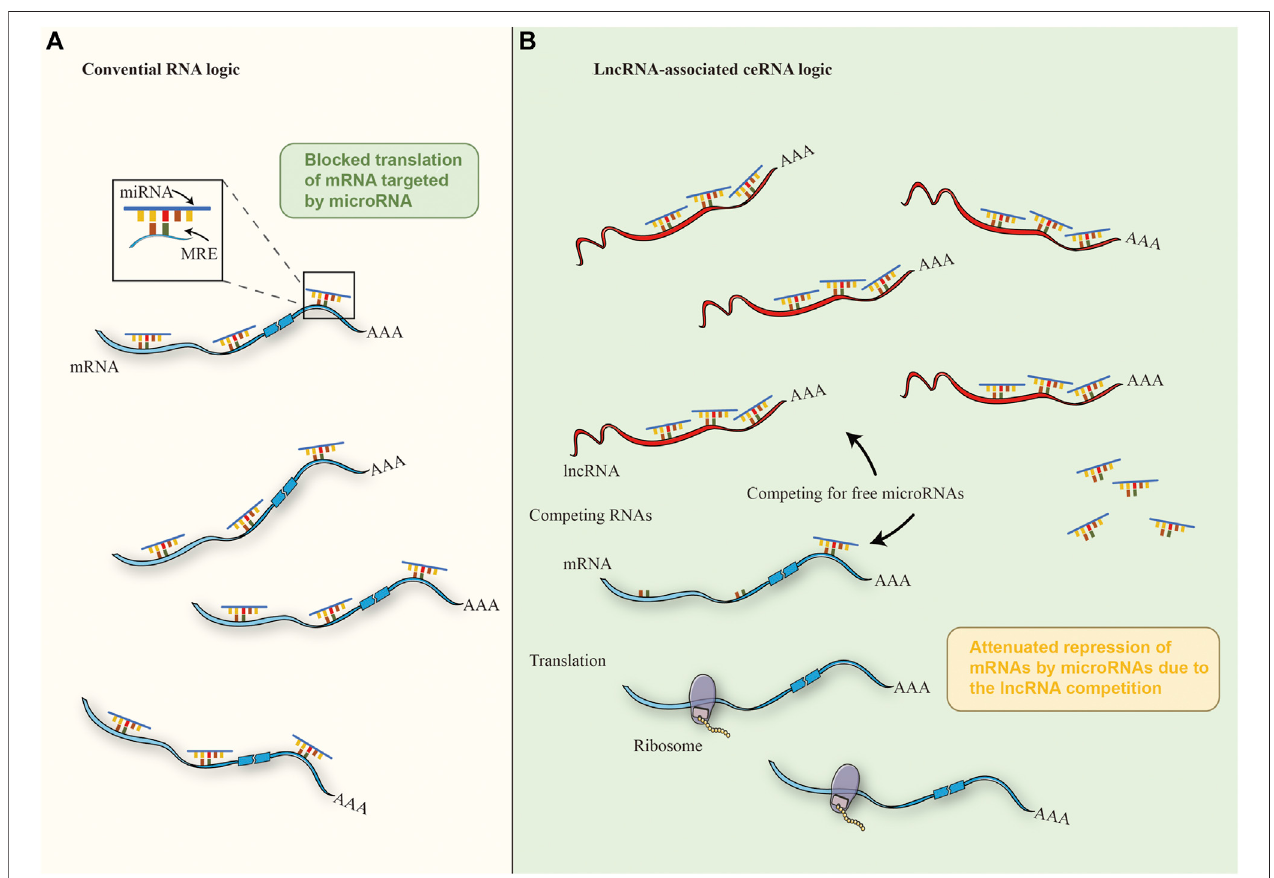
FIGURE 3 | The mechanism of ceRNA. (A) In the cytoplasm, miRNAs could regulate 3 ′ - UTR of mRNAs through base pairing with partial complementarity in the conventional crosstalk of RNA transcripts, thus inhibiting mRNAs. (B) Under the ceRNA mechanism of cancer cells, miRNAs are isolated from each other by abnormally expressed lncrna and MREs, thus reducing the interaction between miRNA and mRNA, thereby weakening the inhibition of downstream mRNA.